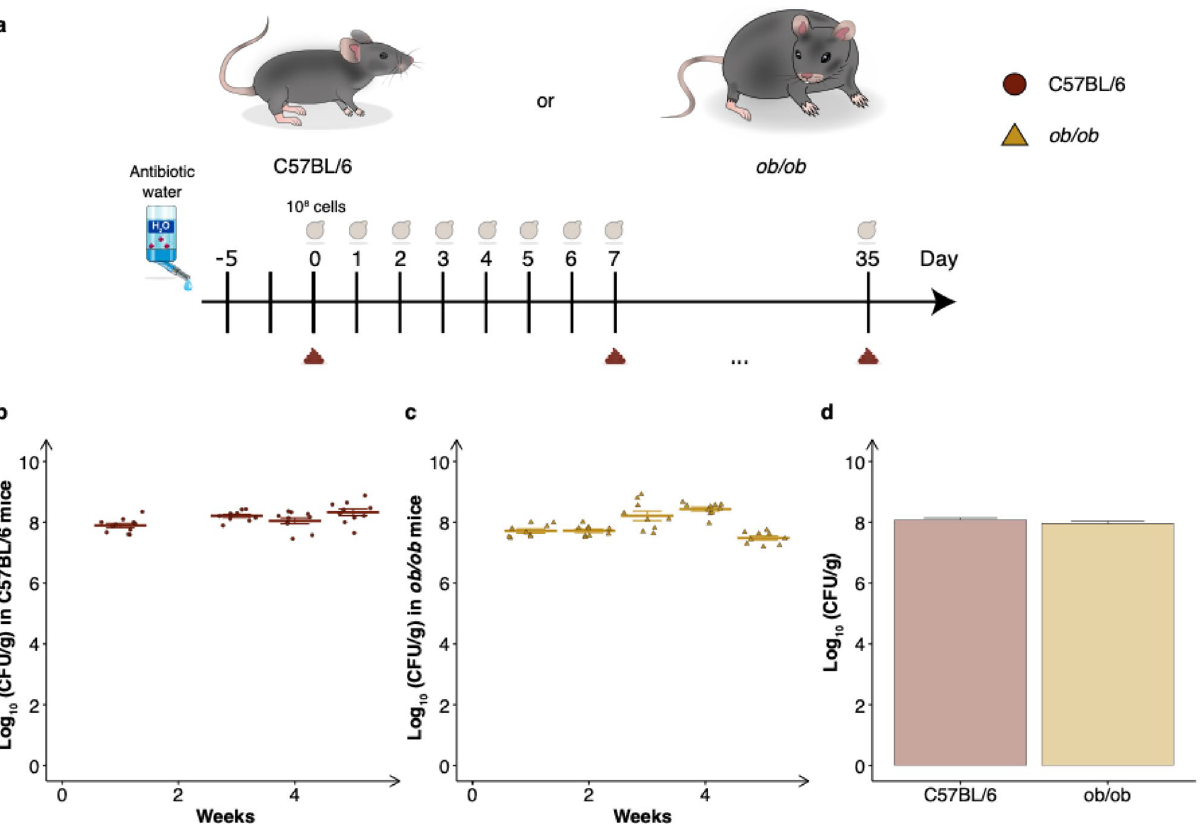
Figure 3. Colonisation assessment of S. boulardii in two different mouse strains receiving antibiotic-treatment. ( a ) A graphical scheme of the study design. The mice were orally administered ~ 10 8 cells of S. boulardii daily for five successive weeks, with weekly faecal collection. ( b ) The time-course of log 10 mean CFU/g of S. boulardii ± SEM over time (weeks) in faeces from C57BL/6 mice. ( c ) The time-course of log 10 mean CFU/g of S. boulardii ± SEM over time (weeks) in faeces from ob/ob mice. ( d ) Bar plot of the mean CFU/g assessed in the faeces over the same period. Each dot represents the log 10 CFU/g S. boulardii in one